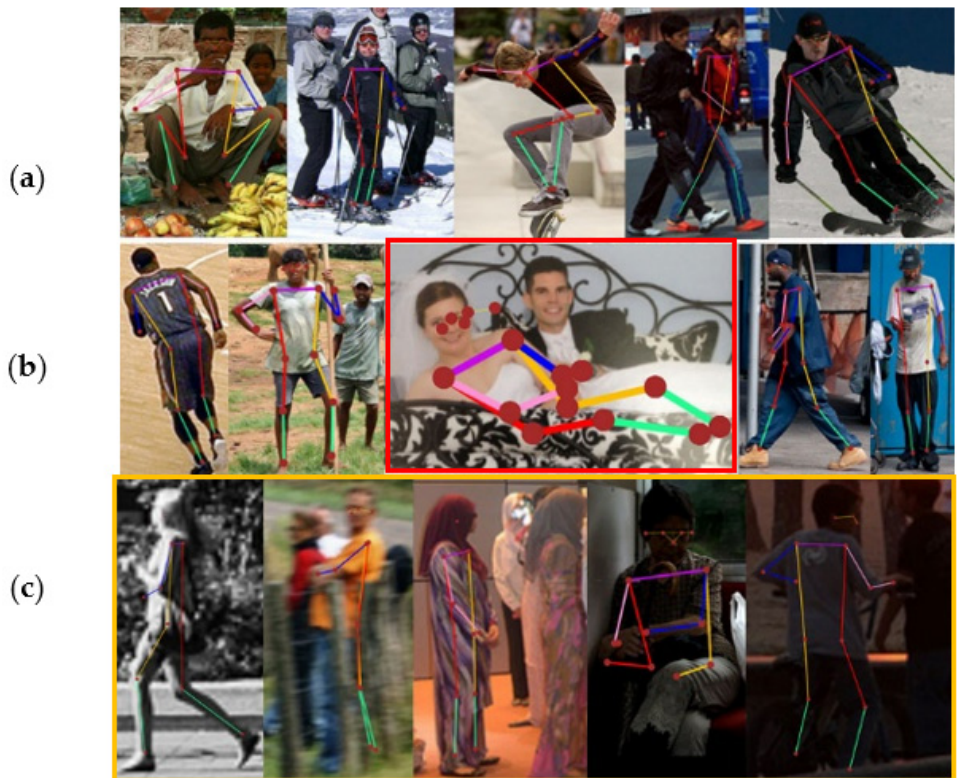
Figure 2. Visualization of the pose estimation results of Cofopose using some image samples from the MS-COCO dataset. Rows ( a , b ) are results estimated from images with good illumination, with the exception of the picture with the red border from row ( b ), which is occluded by clothes. Even though the image with the red border looks more occluded, Cofopose was able to estimate the pose accurately; ( c ) shows Cofopose results on blurred and low-illumination images. Table 5. AP and inference speed results on COCO val. HRNet and Transpose are trained with 210 and 240 epochs, respectively, whereas Cofopose is trained with 50 epochs. Our network achieves a competitive speed/accuracy trade-off.